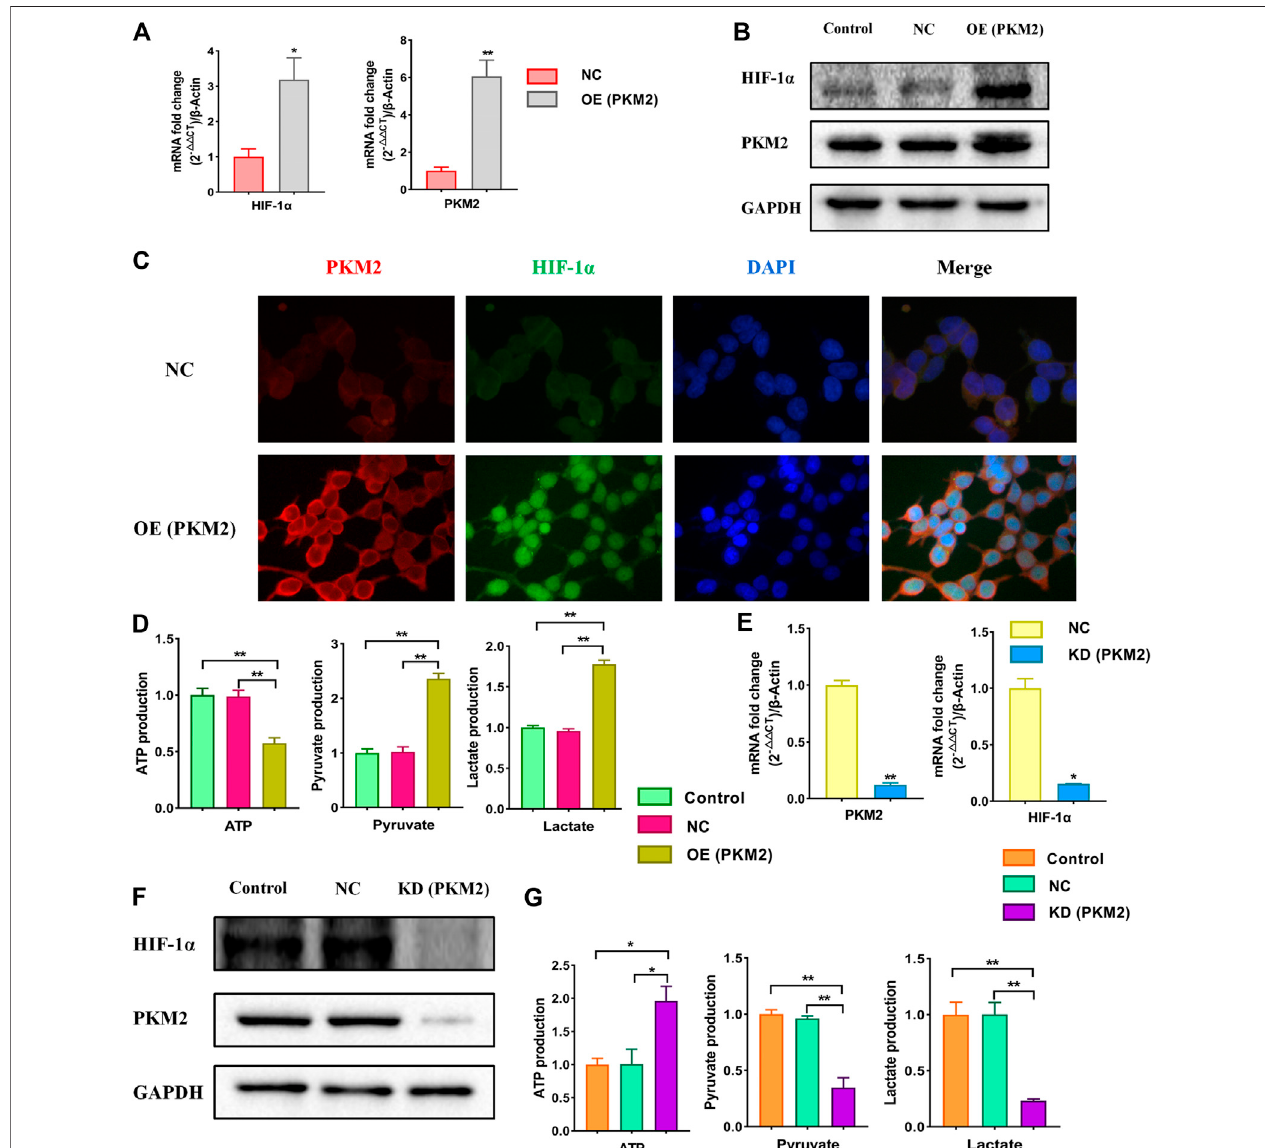
FIGURE 6 | Effects of over-expression and knockdown of PKM2 on relative markers in HEK293T cells. Cells were divided into following groups: conrtol, negative control (NC), PKM2-overexpression group (OE) and PKM2-knockdown group (KD). (A) Effects of over-expression of PKM2 on mRNA levels of HIF-1 α and PKM2 were examined by using qPCR. (B) Effects of over-expression of PKM2 on proteins of HIF-1 α and PKM2 in HEK293T cells were examined by using western blotting. (C) Effects of over-expression of PKM2 on immuno fl uorescence staining of HIF-1 α and PKM2. (D) Effects of over-expression of PKM2 on changes of ATP, pyruvate and lactate using kits. (E) Effects of knockdown of PKM2 on mRNA levels of HIF-1 α and PKM2 in HEK293T cells were examined by using qPCR. (F) Effects of knockdown of PKM2 on proteins of HIF-1 α and PKM2 in HEK293T cells were examined by using western blotting. (G) Effects of knockdown of PKM2 on changes of ATP, pyruvate and lactate using kits. * p < 0.05 and ** p < 0.01.